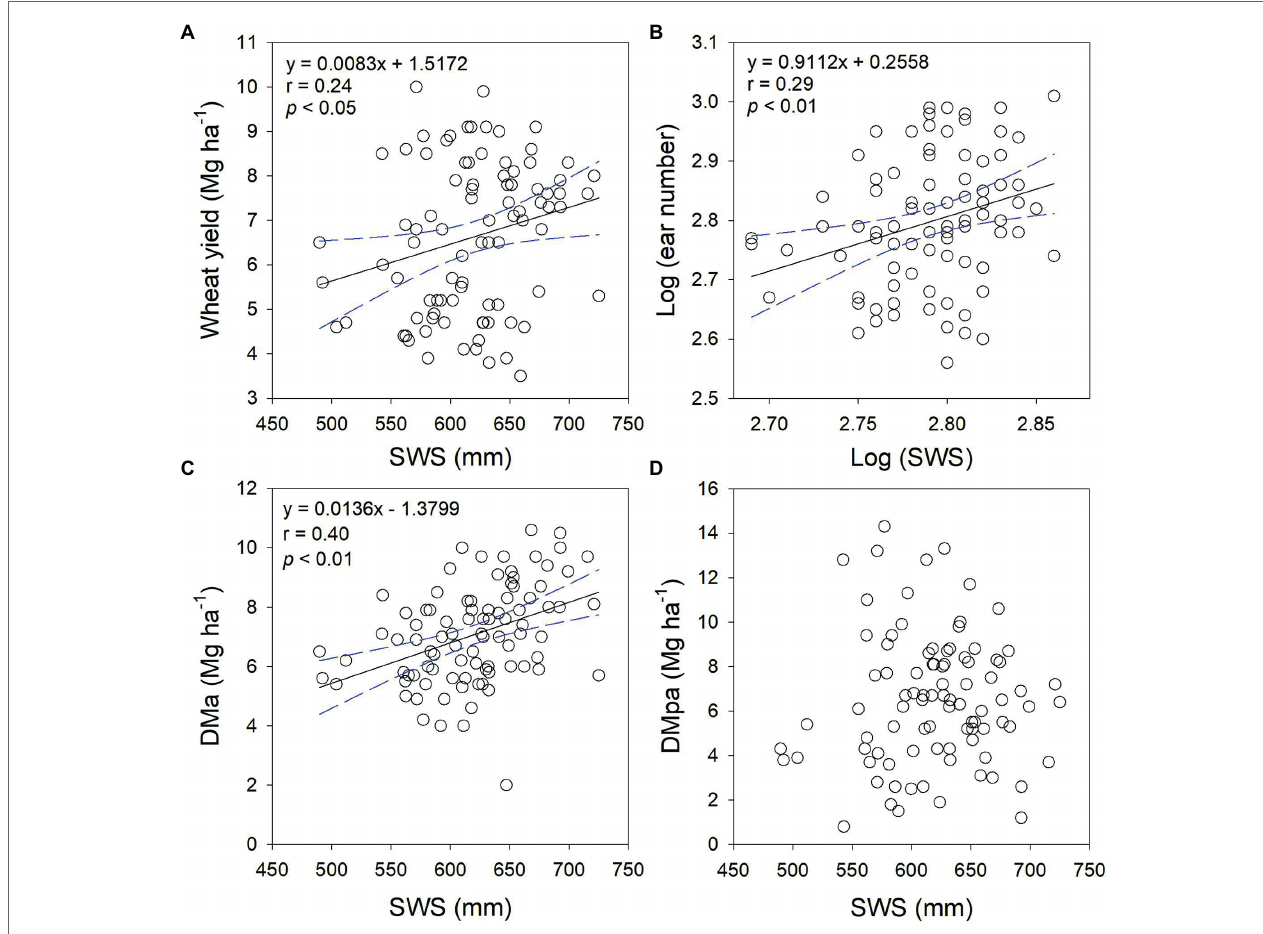
FIGURE 6 | Relationships between wheat yield (A) , ear number (B) , dry matter accumulation at anthesis (DMa, C ), and dry matter accumulation during post- anthesis (DMpa, D ) and soil water storage (SWS) before winter wheat sowing,